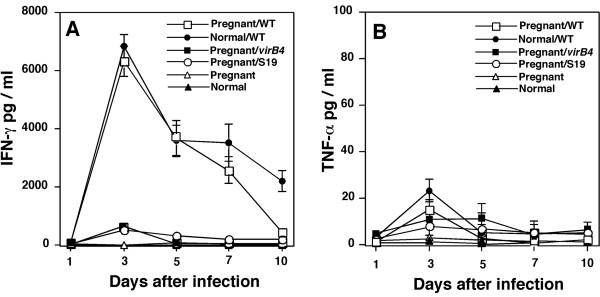
Transient increase in IFN-γ in pregnant mice induced by B. abortus infection. The IFN-γ (A), and TNF-α (B) serum levels were measured in each mouse by ELISA at the indicated numbers of days after infection. The mean and SE for groups of five mice are shown.